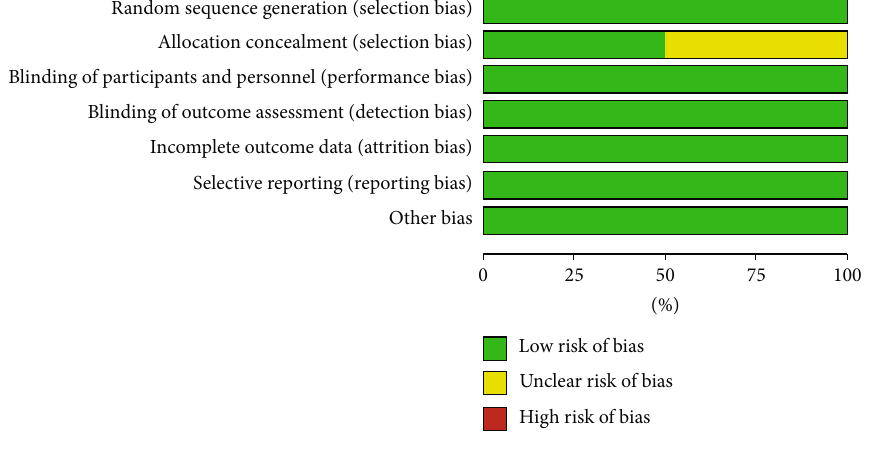
Figure 3: Risk of bias